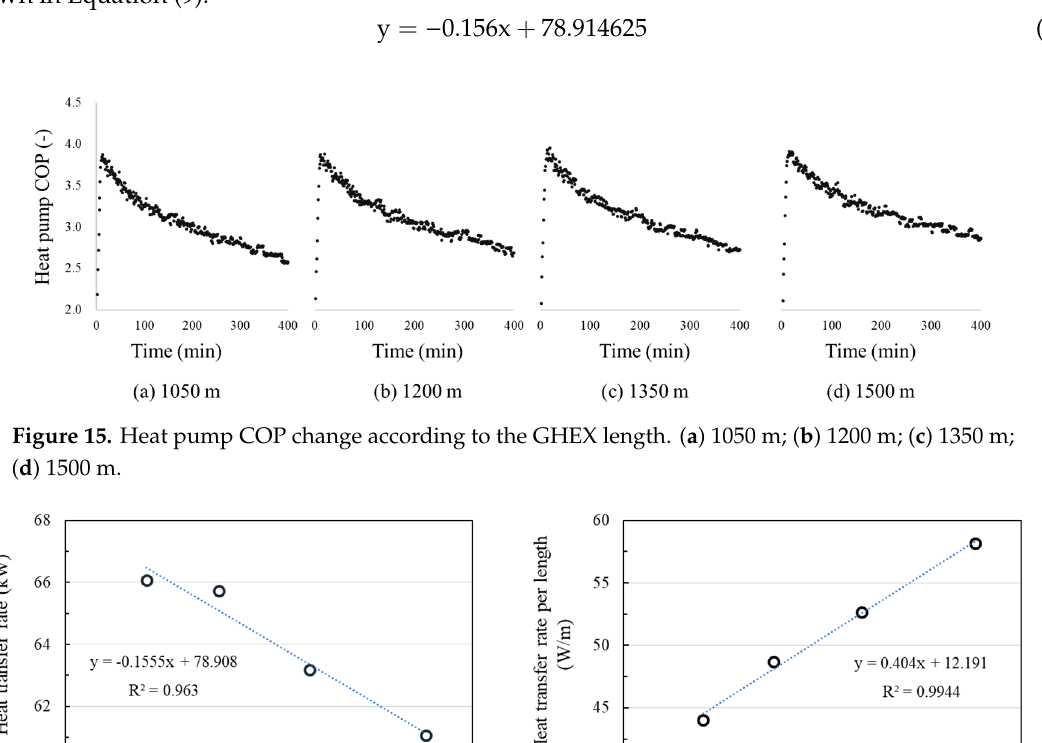
Figure 14. Heat transfer rate change according to the GHEX length. ( a )1050 m; ( b )1200 m; ( c ) 1350 m; ( d ) 1500m.